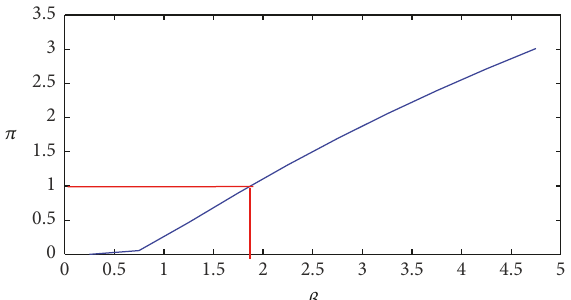
Figure 2: Variation of the present economic burden/premium ( 𝜋 ) with respect to rate of infection ( 𝛽 ). Here 𝛾 = 0.55 and 𝛿 = 0.05 .